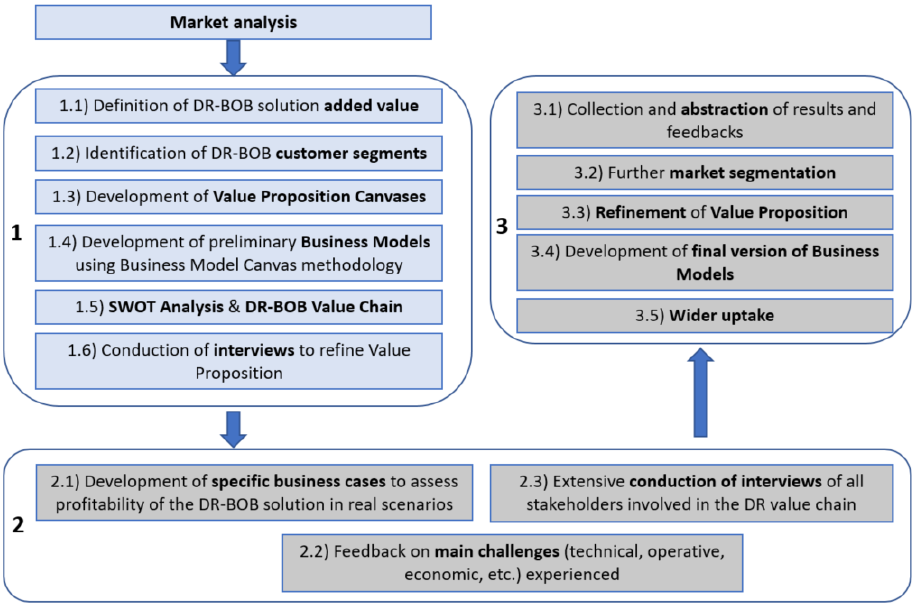
Figure 1. Approach for Business Model development.